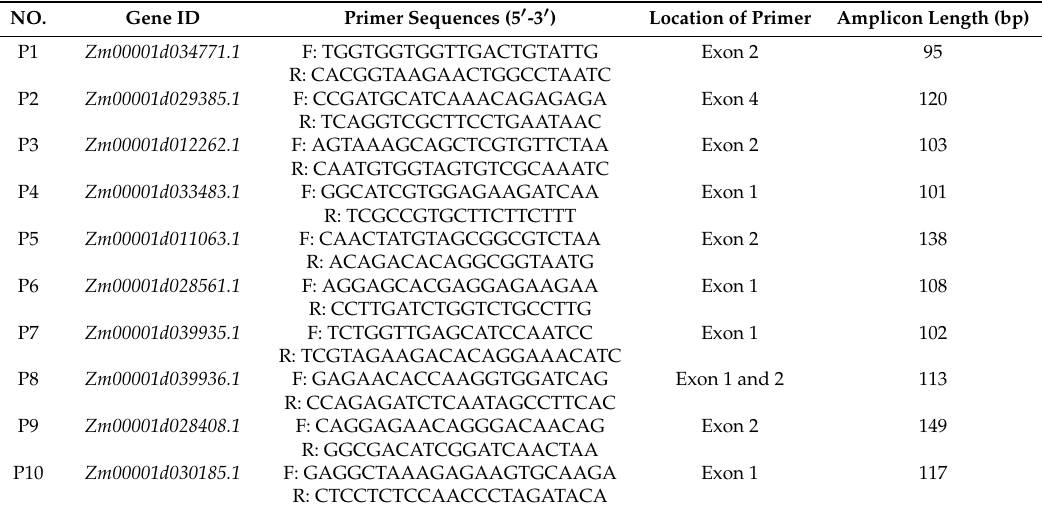
Table 2. The qPCR primers of ten